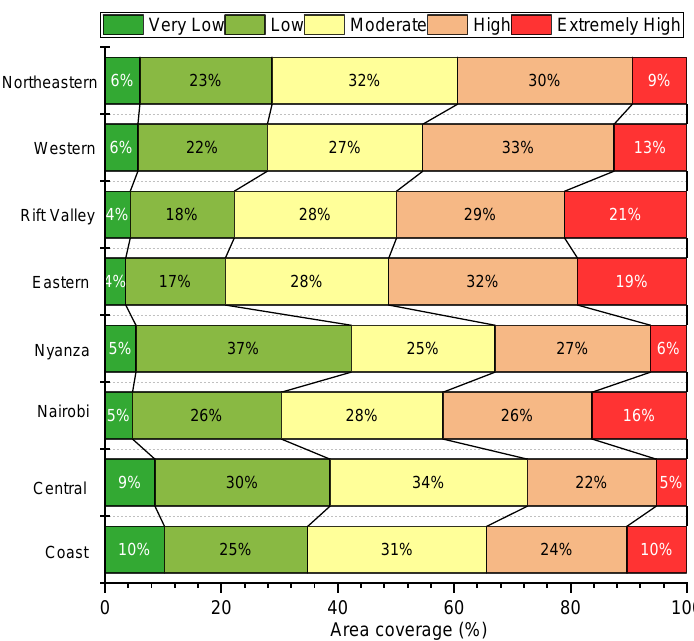
Figure 7. Area coverage of the five landslide susceptibility levels in each province.